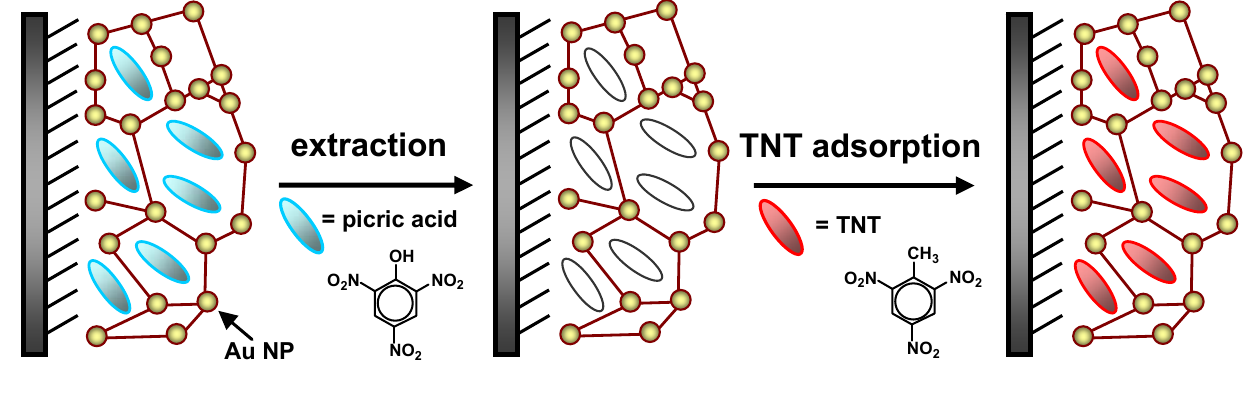
Figure 6. Imprint of molecular recognition sites for TNT in an oligoaniline-crosslinked Au nanoparticle (NP) film polymerized at the Au electrode. Reprinted with permission from [112]. Copyright 2008 American Chemical